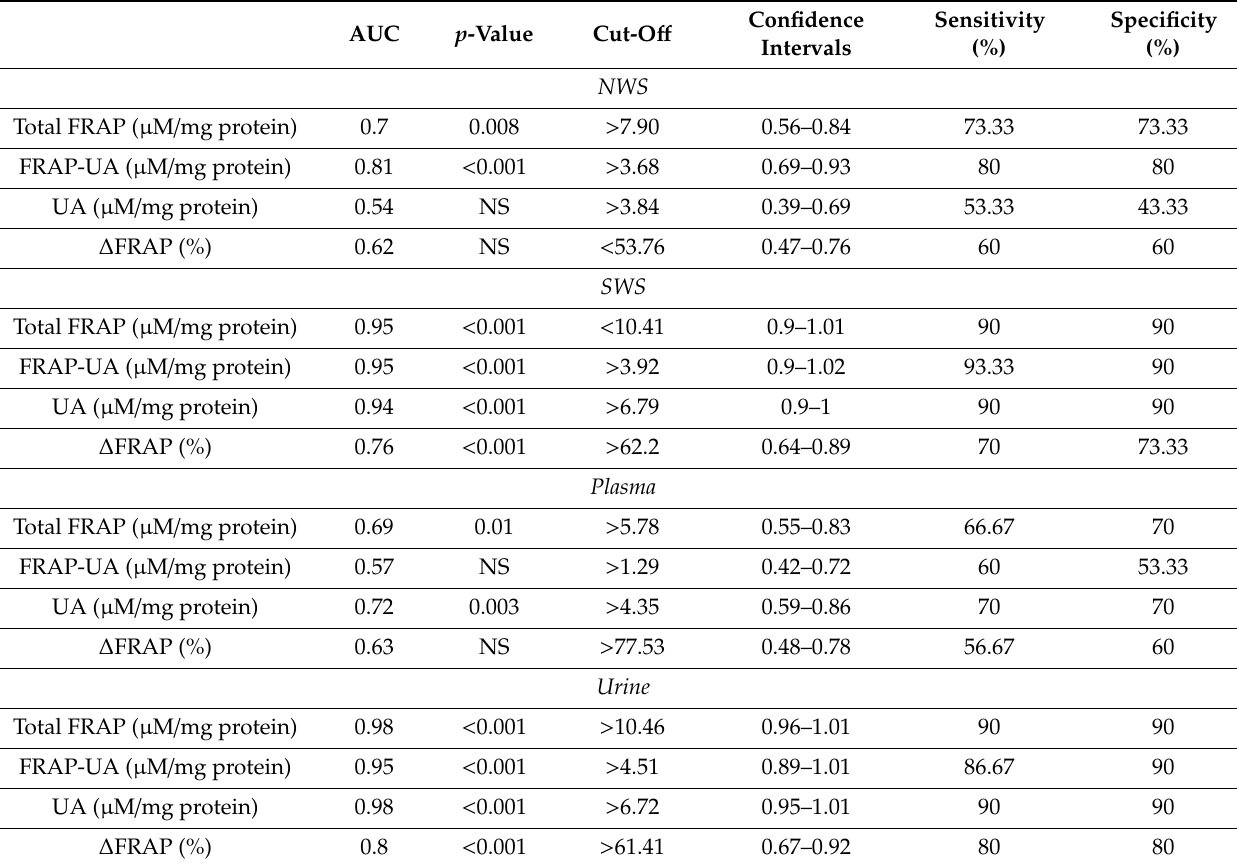
Table 3. Receiver operating characteristic (ROC) analysis of total antioxidant capacity measured by FRAP in saliva, plasma and urine of children with chronic kidney disease (CKD) and healthy controls. Confidence AUC Cut-O ff